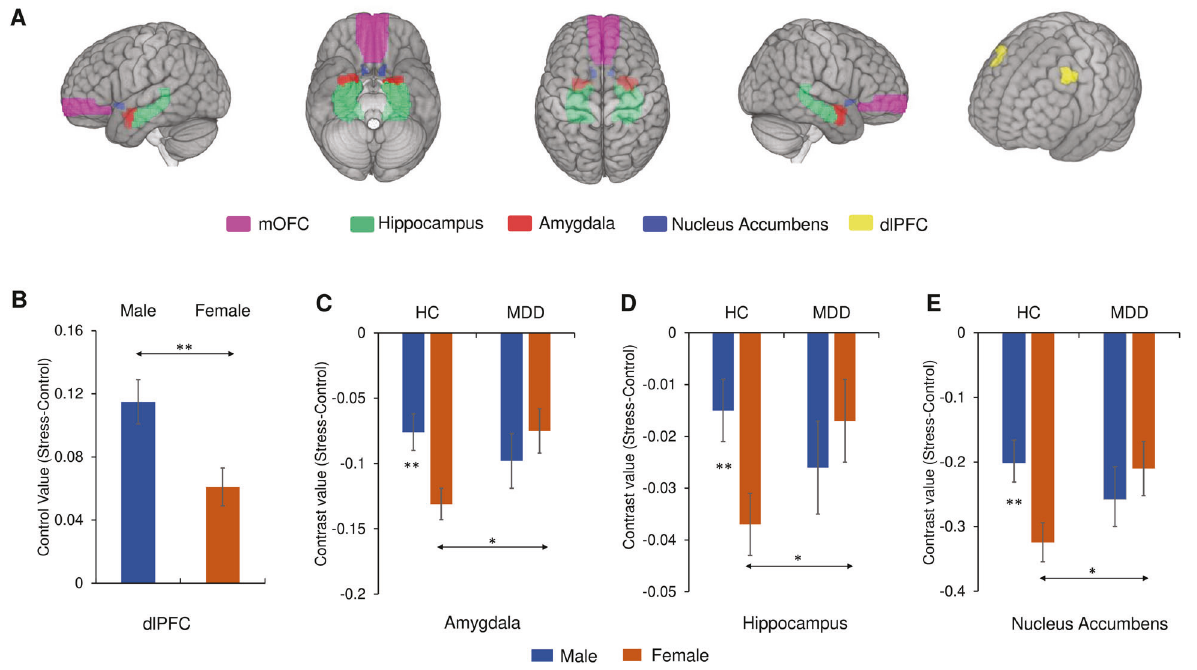
Fig. 1 Neural responses to acute psychosocial stress. A Location of medial orbitofrontal cortex, hippocampus, amygdala, nucleus accumbens, dorsolateral prefrontal cortex. B Sex differences in dorsolateral prefrontal cortex. C Sex × Diagnosis interaction effect in amygdala. D Sex × Diagnosis interaction effect in hippocampus. E Sex × Diagnosis interaction effect in nucleus accumbens. Estimated-mean are plotted, and error bars represents standard error (SE). mOFC medial orbitofrontal cortex, dlPFC dorsolateral prefrontal cortex, HC healthy controls, MDD major depressive disorder. * p Bonferroni < 0.05, ** p Bonferroni <